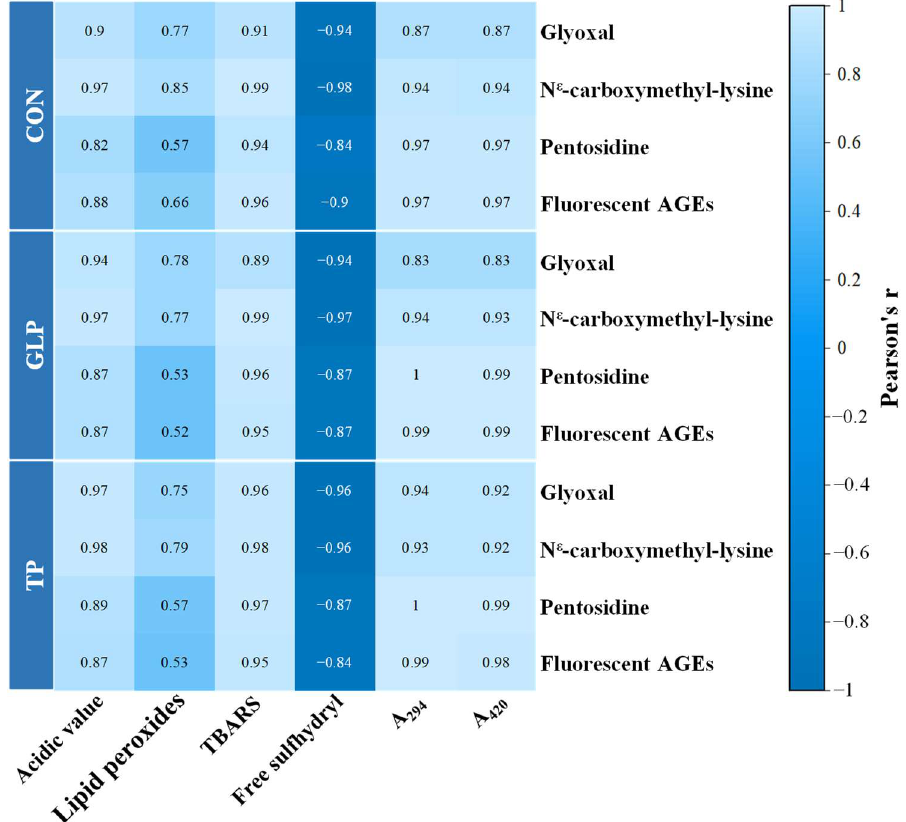
Figure 7. Correlation analysis of lipid oxidation, protein oxidation, and Maillard reaction with advanced glycation end product formation of frozen chicken meatballs. GLP, guava leaf polyphenols; TP, tea polyphenol; CON, control.